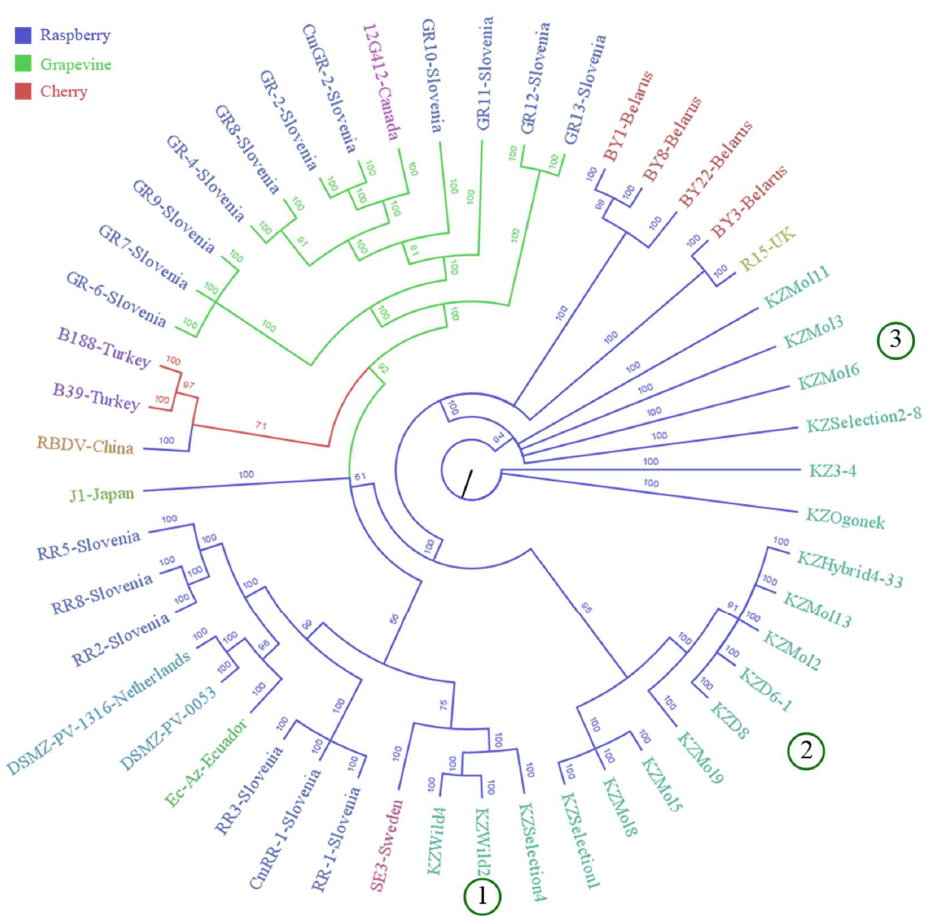
Figure 2. Cladogram constructed from all publicly available complete RNA2 sequences of RBDV using Bayesian algorithm. Branches are coloured according to the plant host, while isolates are coloured according to their countries of origin. Isolates introduced in this study (prefix KZ) are divided into three groups (1–3) according to their position in the cladogram. Table 3. Molecular characterization of mutant spectra for RNA2 of RBDV isolates: mutation fre- quency per genome and per gene. Numbers of SNPs, indels, nucleotide diversity, and Shannon in- dex were estimated by retracting the 10 −3 error rate correction.